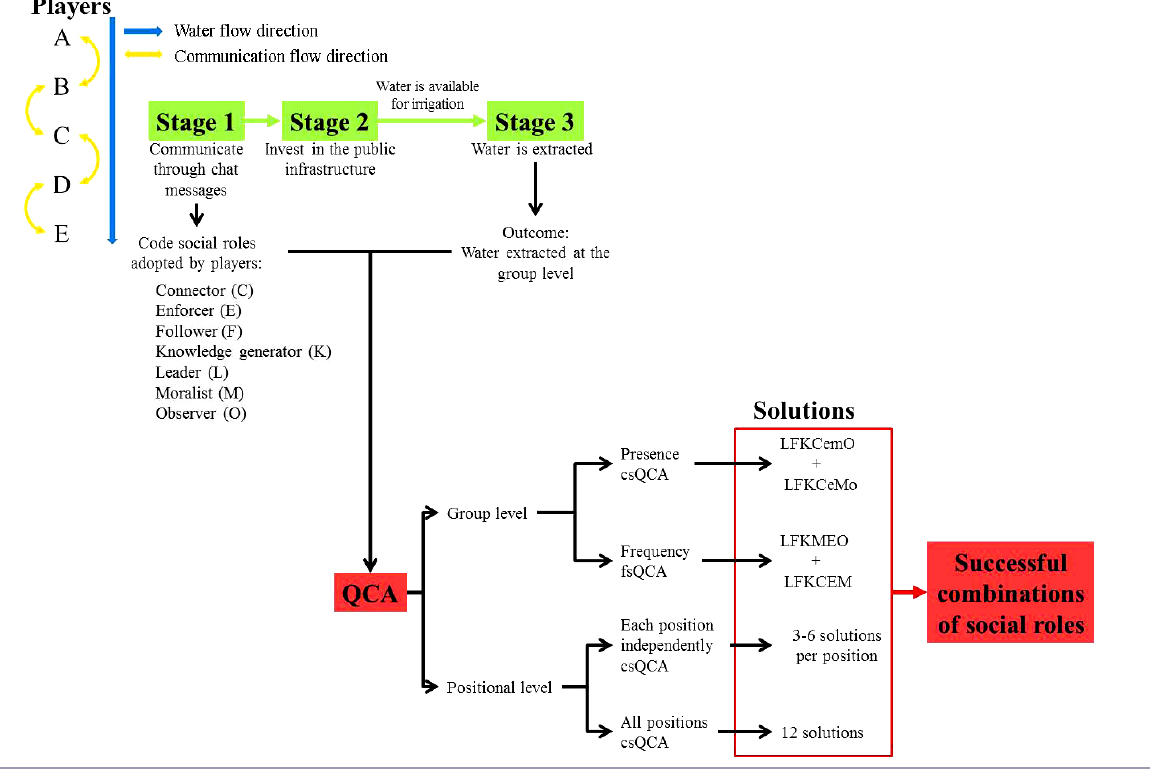
Fig. 2 . Graphical summary of methods and results. Following qualitative comparative analysis (QCA) notation, in the solution box an uppercase letter means that the condition is present, and a lowercase letter means that